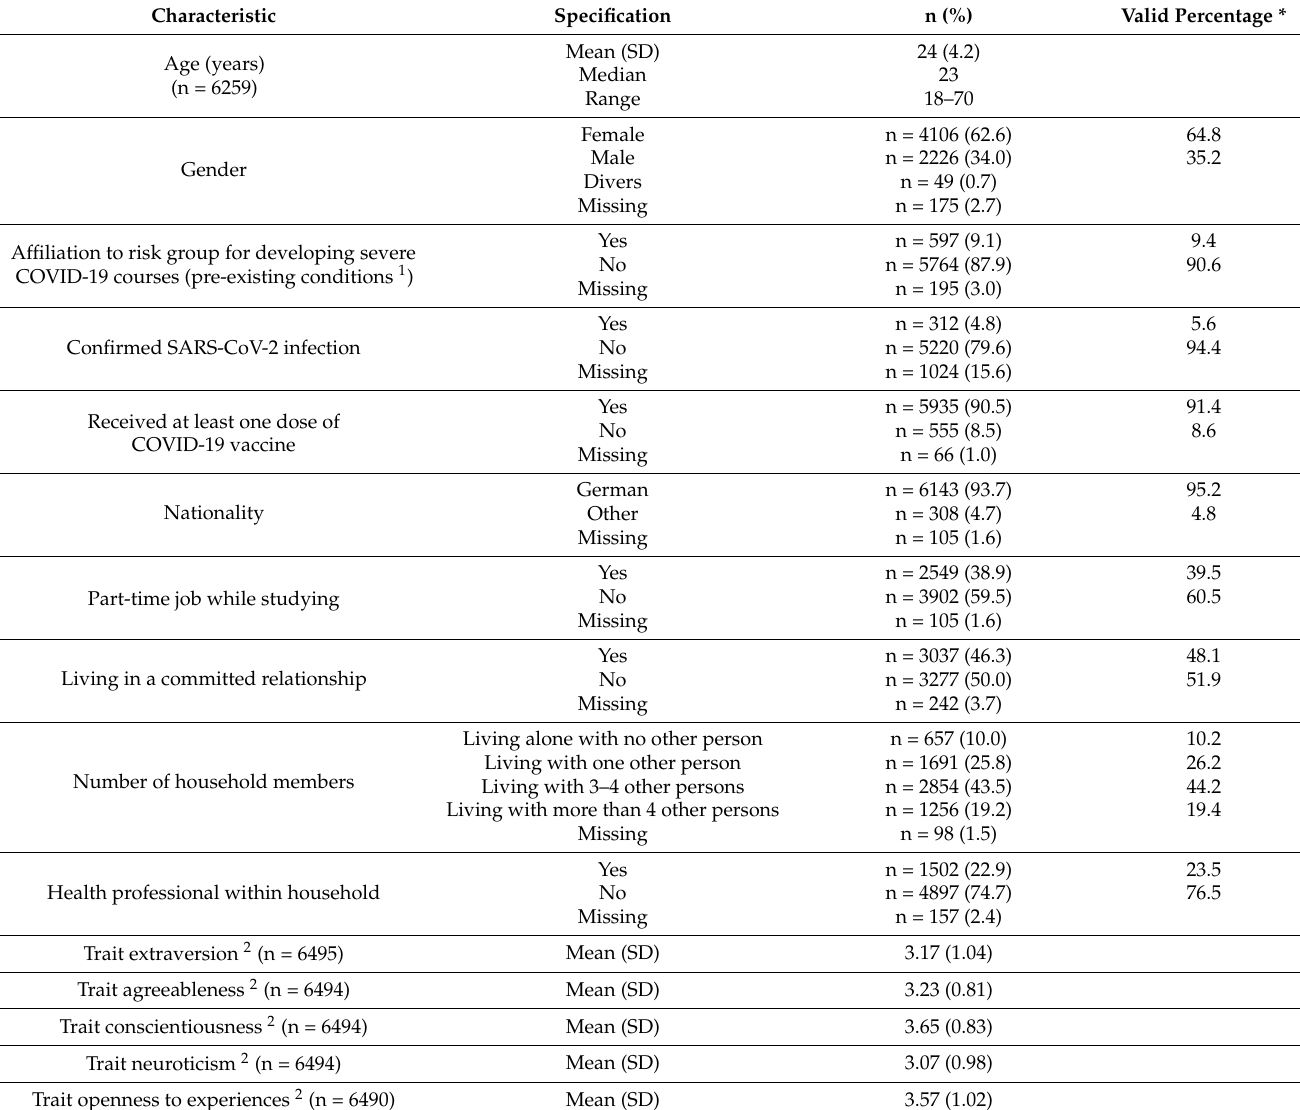
Table 1. Individual variables—characteristics of higher education